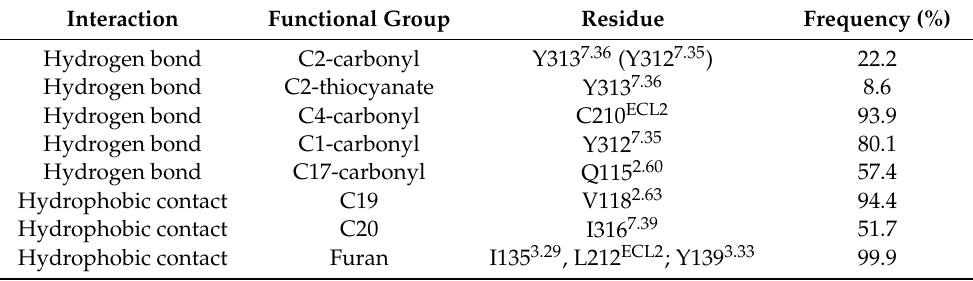
Table 5. Interactions between RB-64 ( 7 ) and the KOR during MD